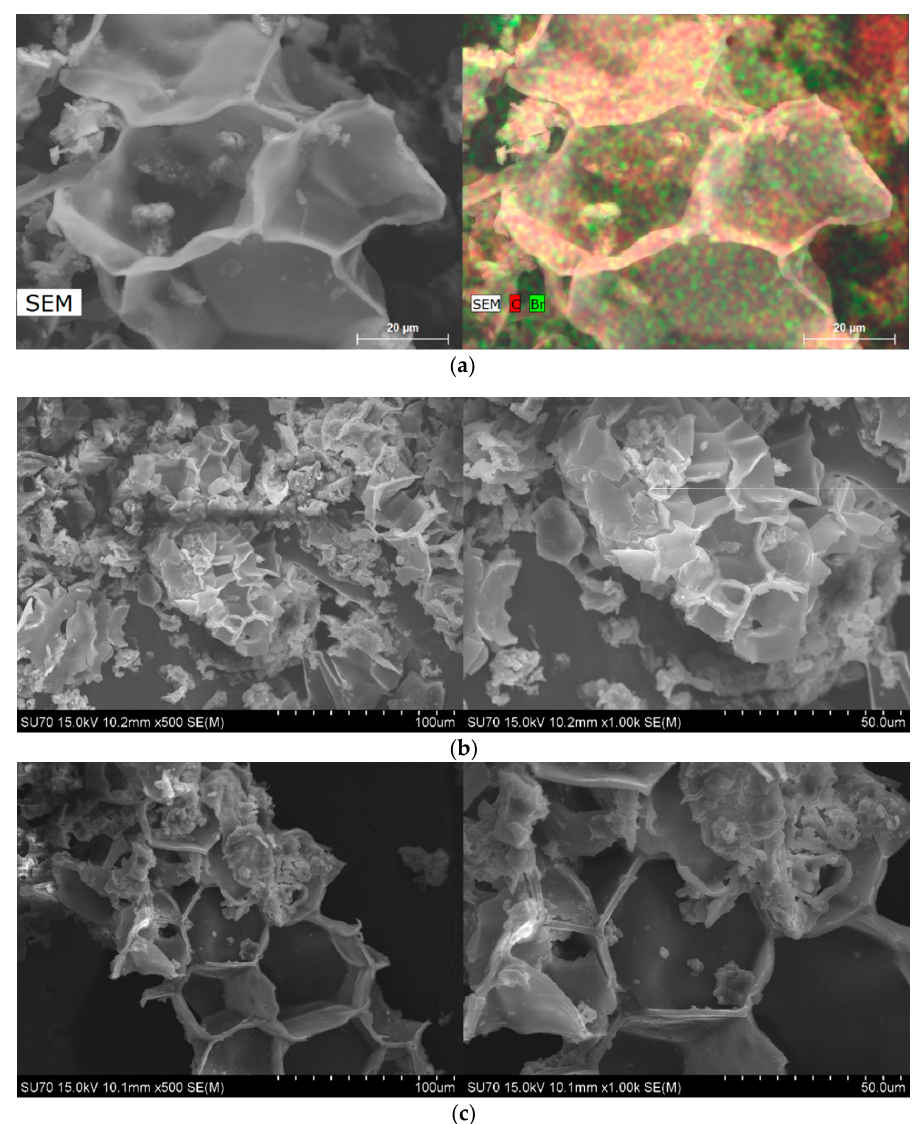
Figure 2. SEM image and EDX bromine mapping of C-B i B ( a ) and SEM image of Cork ( b ) and C- g - PMMA ( c ). C- g -PMMA ( c